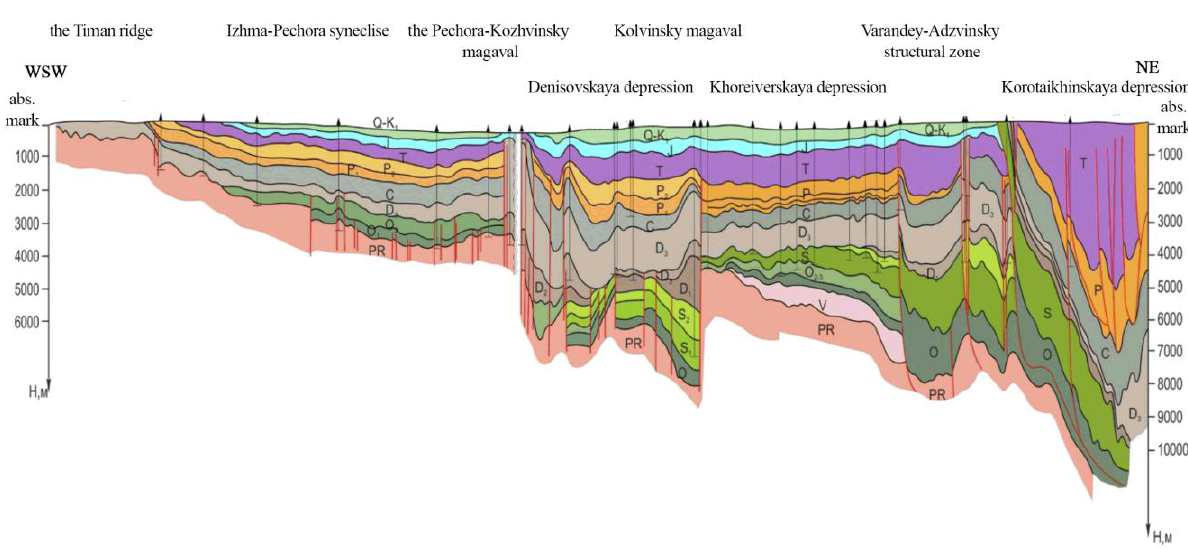
Figure 11. Regional geological section along seismic line 19-RS (see Figure 9) through the main tectonic zones of the Central part of the Timan-Pechora sedimentary basin, after [41].